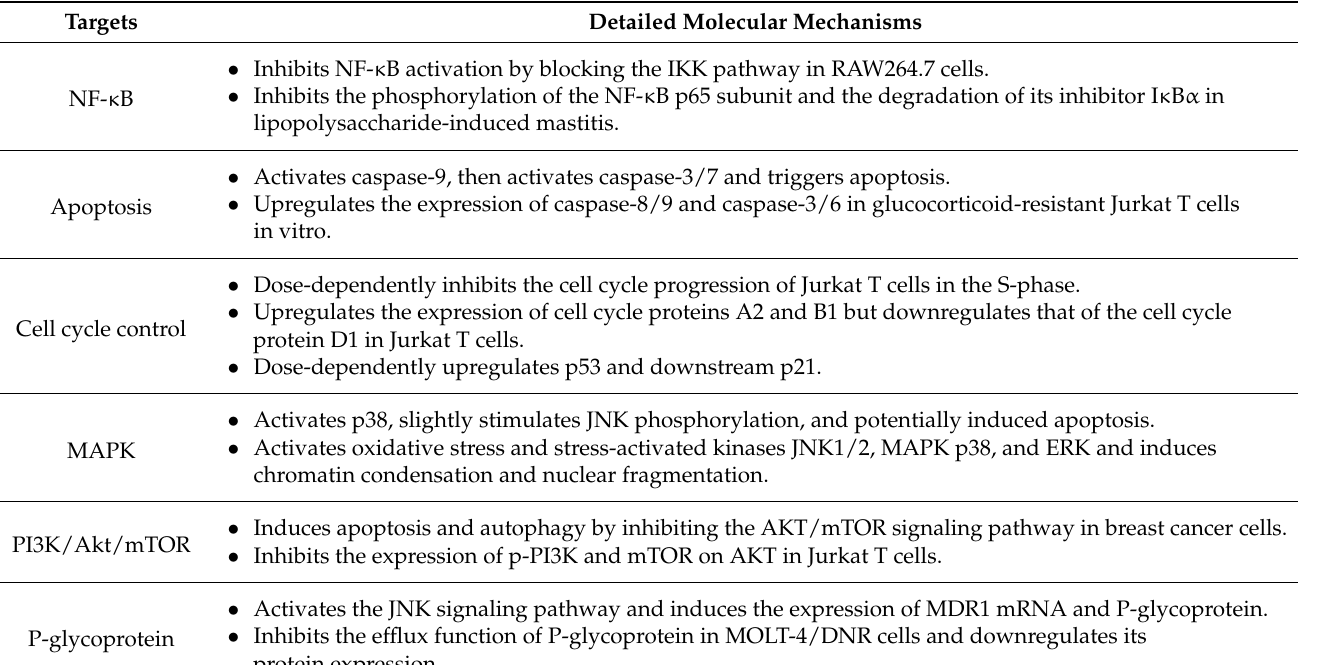
Table 3. Detailed molecular mechanisms of cepharanthine in